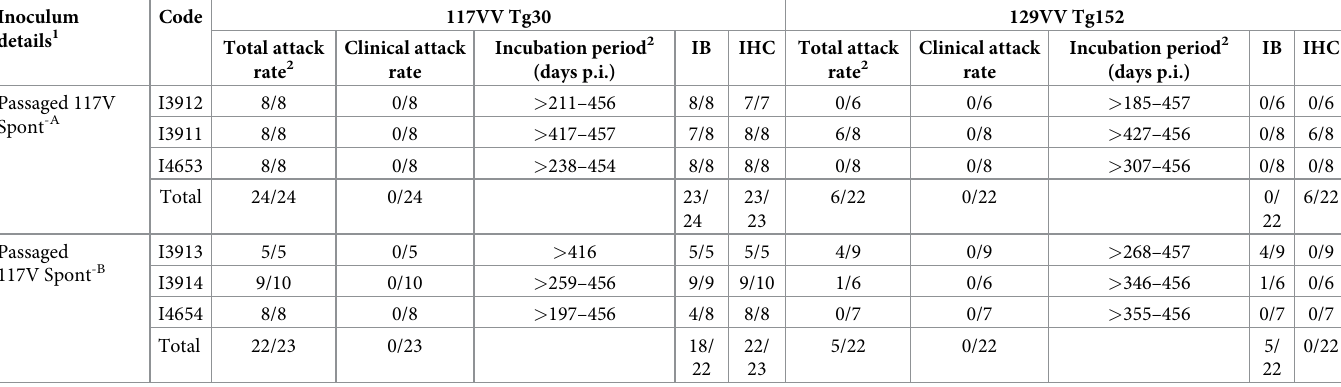
Table 2. Secondary passage of spontaneous 117V prion isolates in 117VV Tg30 and 129VV Tg152